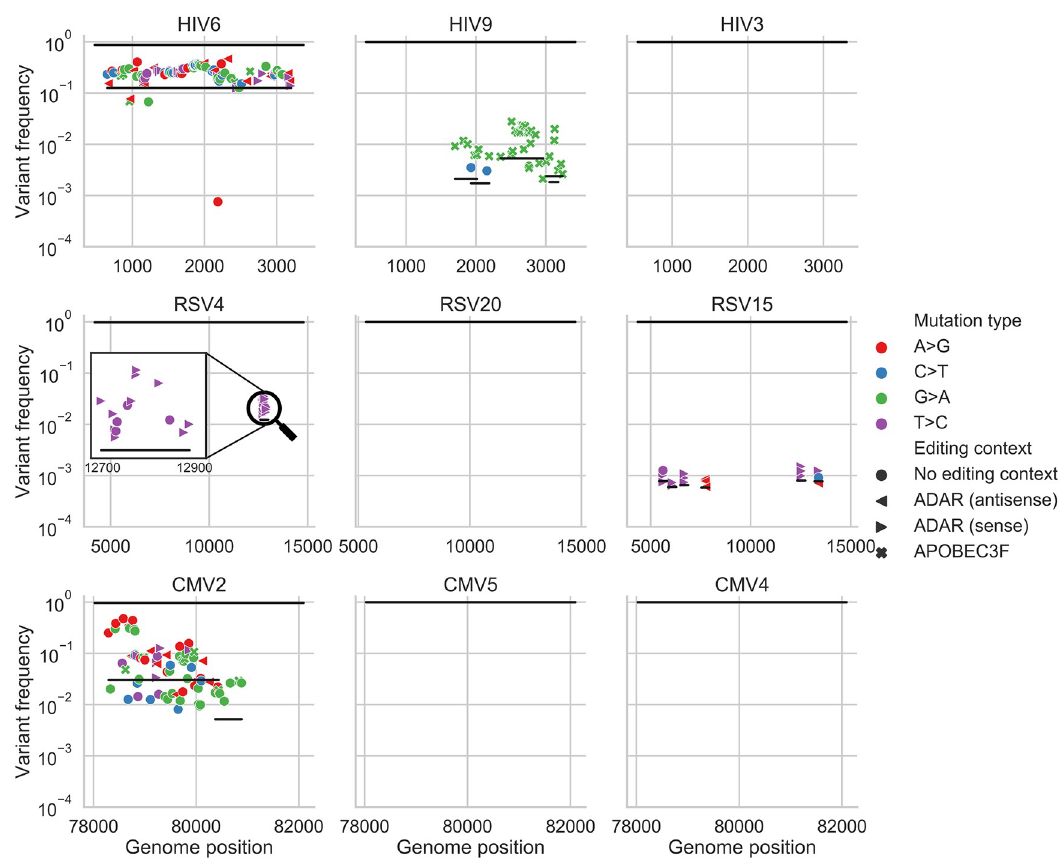
Fig 4. Haplotype reconstruction based on co-occurrence of variants on the same reads. Shown are inferred haplotypes (lines) based on consecutive significant associations of pairs of variants (shapes) one to another on the same read. The uppermost line in each panel represents the consensus sequence, which by definition is the major haplotype in each sample. Both HIV6 and CMV2 samples show strong evidence of an additional haplotype, which is likely a second founder genotype. Sample HIV9 shows evidence of G > A hyper-mutation in the context of APOBEC3 editing, samples RSV4 and RSV15 show evidence of T > C or A > G hyper- mutation in the context of ADAR editing in regions spanning a few hundred bases. The hyper-mutated region in RSV4 sample is magnified for clarity. “Empty” panels signify what are likely single haplotype infections, with no evidence of